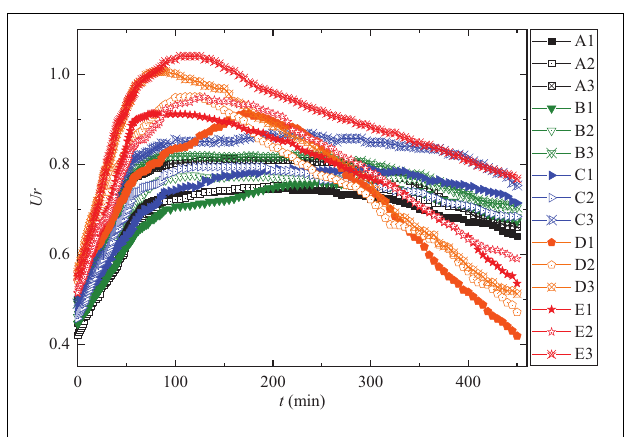
FIGURE 8 | Curves for changes in relative excess pore water pressure.